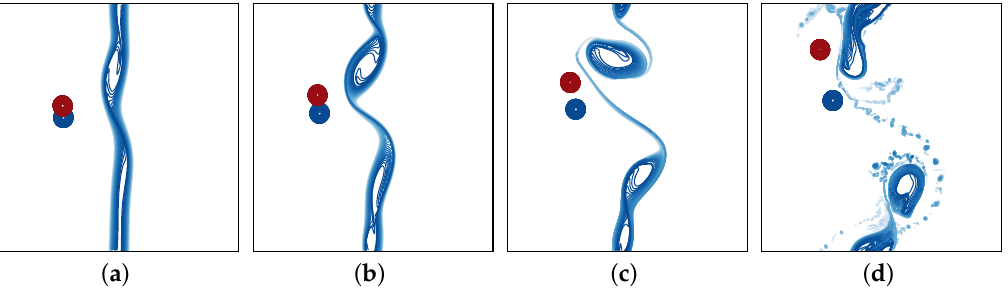
Figure 7. ( a ) Contours of d h / ( d 2 δ = 0.5.